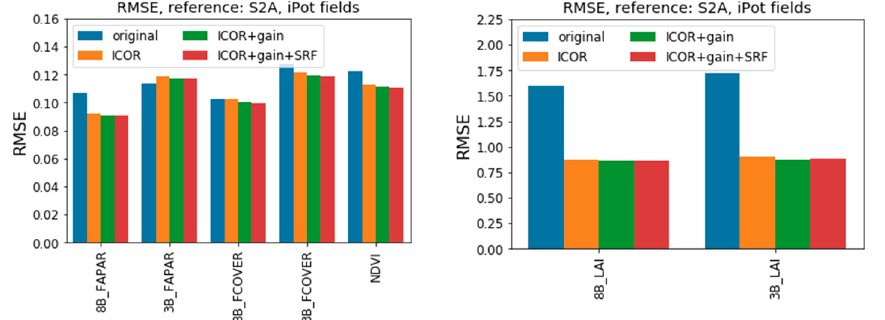
Figure 8. RMSE between S2A and match-ups with other sensors for the different BIOPARs and NDVI (X) and for the original data and various harmonization measures (colors).